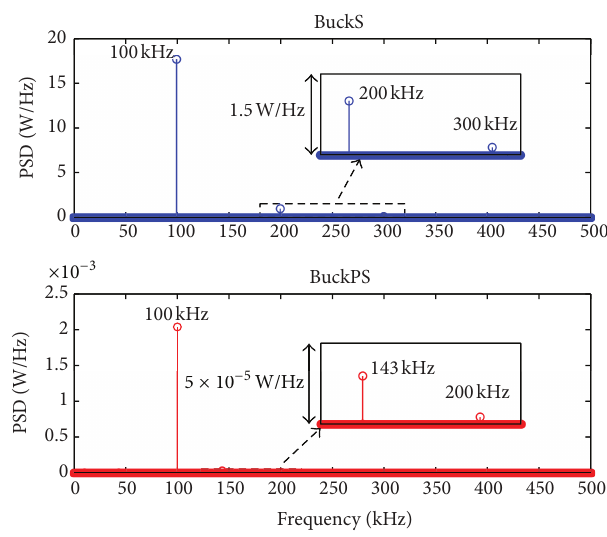
Figure 11: Power spectral density of BuckS and BuckPS.